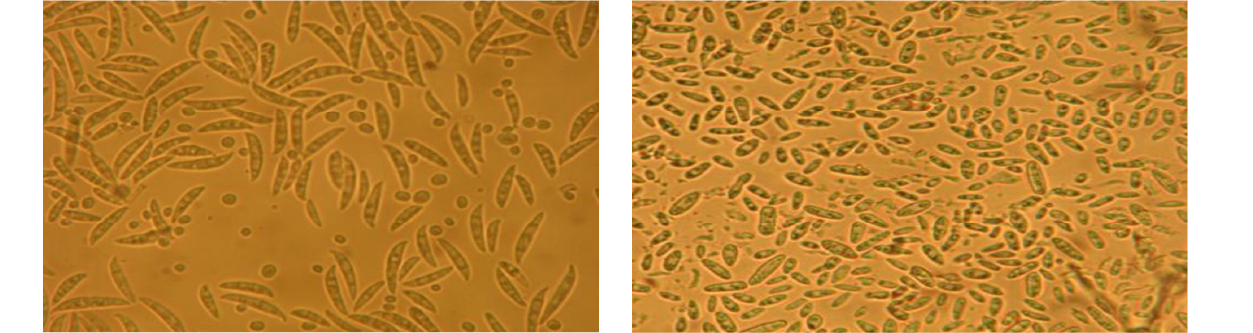
Fig. 5. Micrograph of Fusarium oxysporium Fig. 6. Micrograph of Fusarium verticillioides